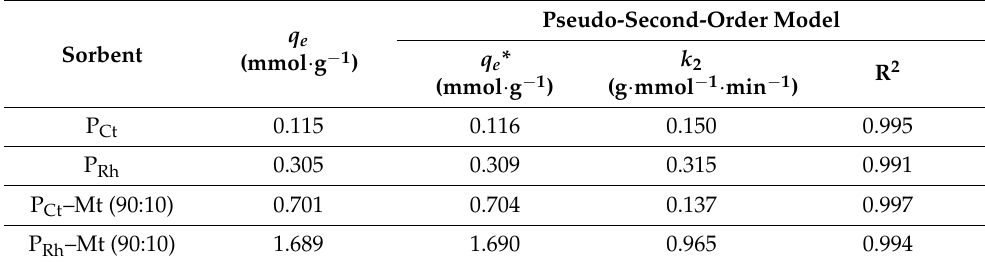
Table 8. Kinetic parameters of theophylline binding by pectin and bicomponent samples at pH 5 after pre-sorption at pH 2 for 120